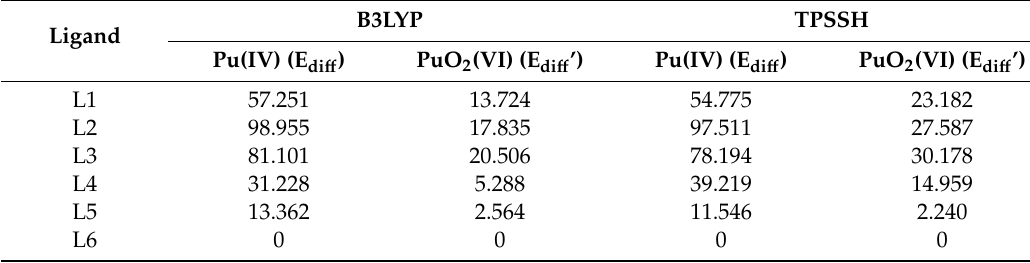
Table 2. Calculated energy di ff erence compared with L6 ligand energy (kcal / mol) for each structure using both